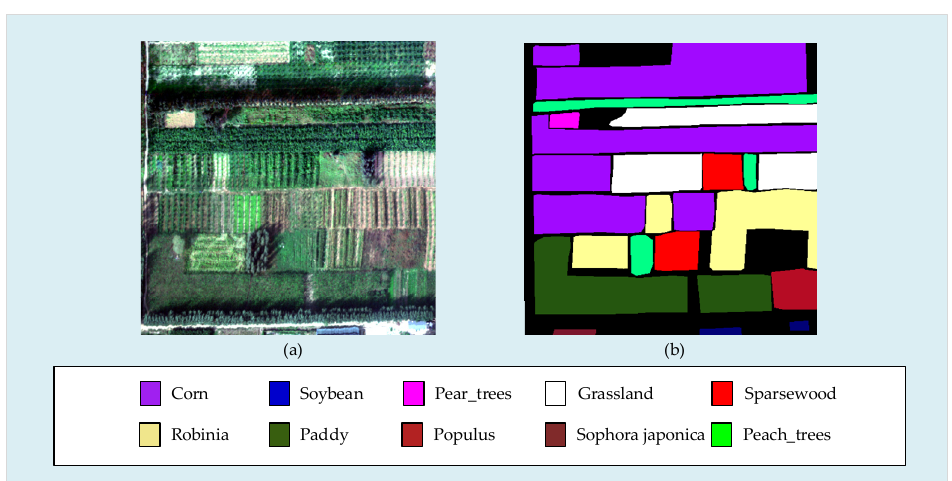
Figure 4. ( a ) The pseudo-colour image of Xiong’an; ( b ) ground truth classification map of Xiong’an.